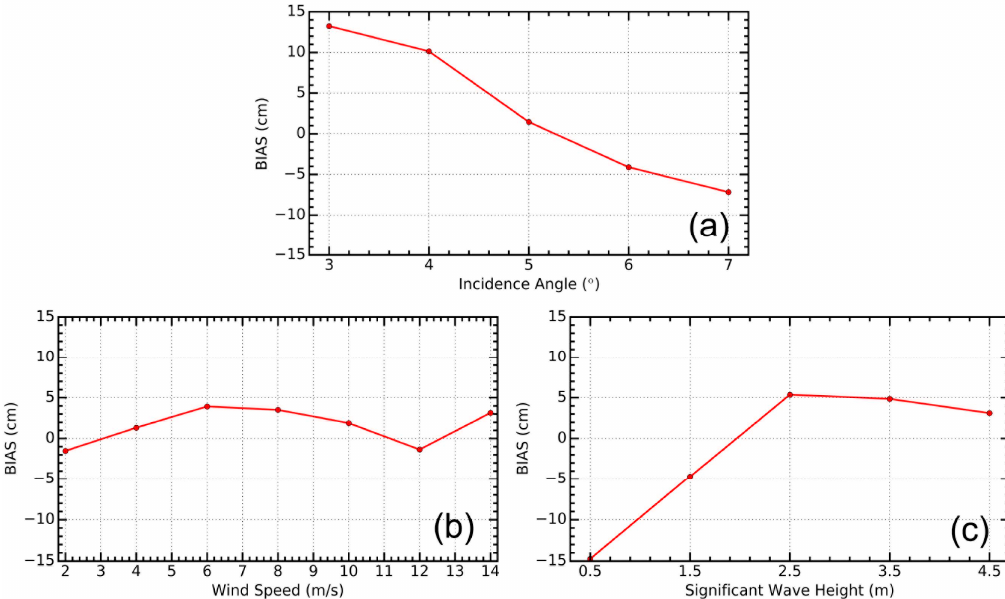
Figure 6. Sea surface height (SSH) parametric bias analysis for ( a ) incidence angle, ( b ) wind speed, and ( c ) significant wave height.